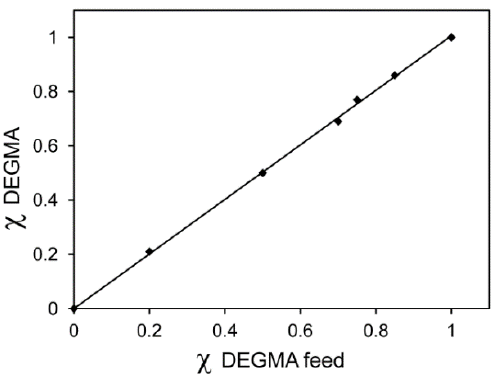
Figure 7. Mol fraction of DEGMA measured in the copolymer by 1 H-NMR as a function of the mole fraction feed ( R 2 = 0.9996).